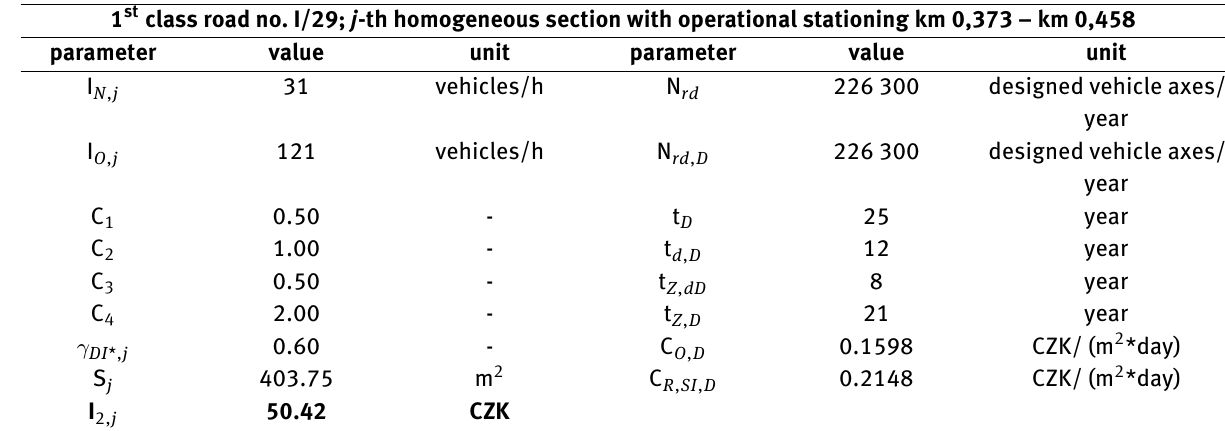
Table 5: The sample of the outputs from the application based on the analytical model for one homogeneous section j of the 1 st class road no. I/29 [1] ANALYTICAL MODEL OUTPUTS – PARAMETER I